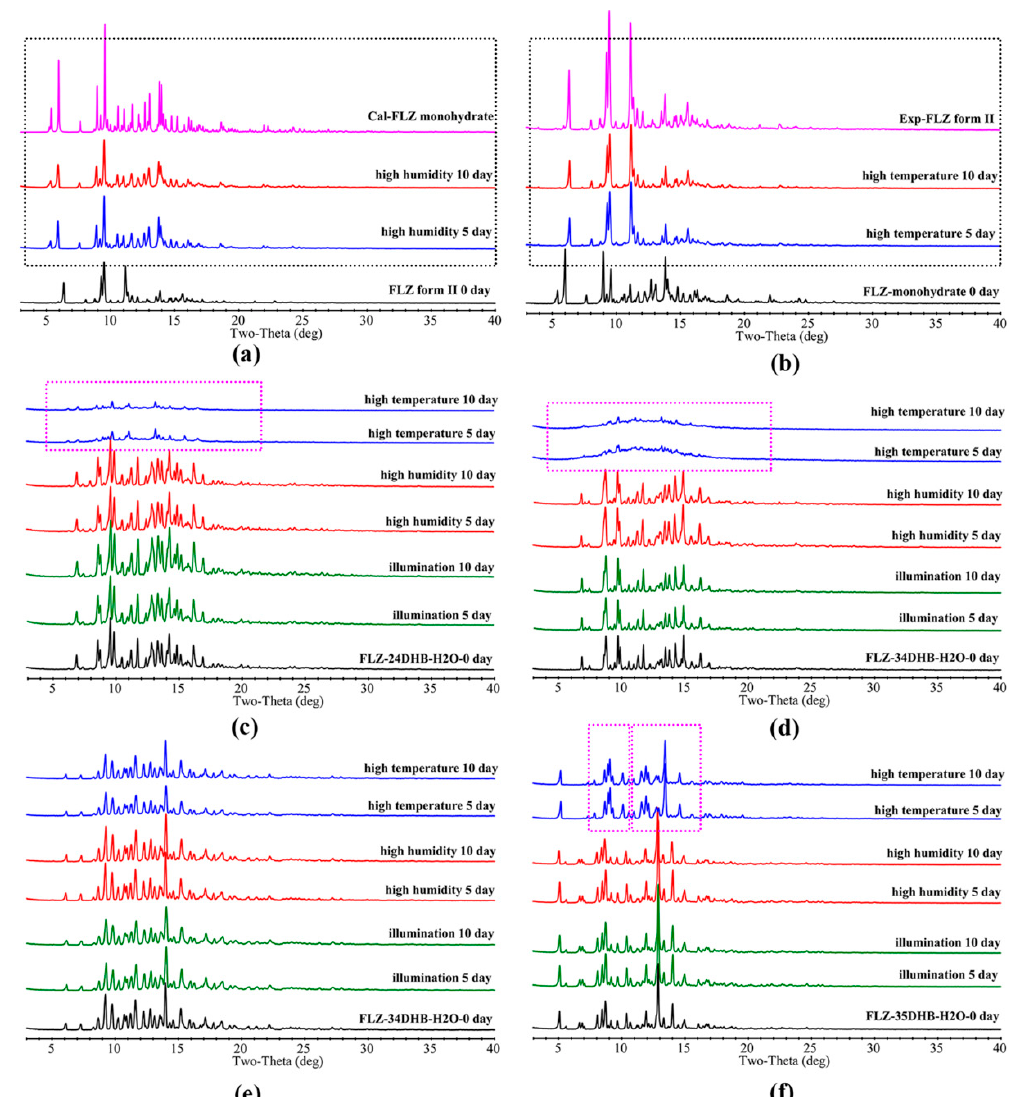
Figure 10. Accelerated stability results of ( a ) FLZ, ( b ) FLZ monohydrate, ( c ) FLZ − 24DHB − H 2 O (1:0.5:1), ( d ) FLZ − 34DHB − H 2 O (1:0.5:1), ( e ) FLZ − 34DHB − H 2 O (1:1:1), ( f ) FLZ − 35DHB − H 2 O (1:1:1). The dotted box in the figure highlights peaks of transformed phases.